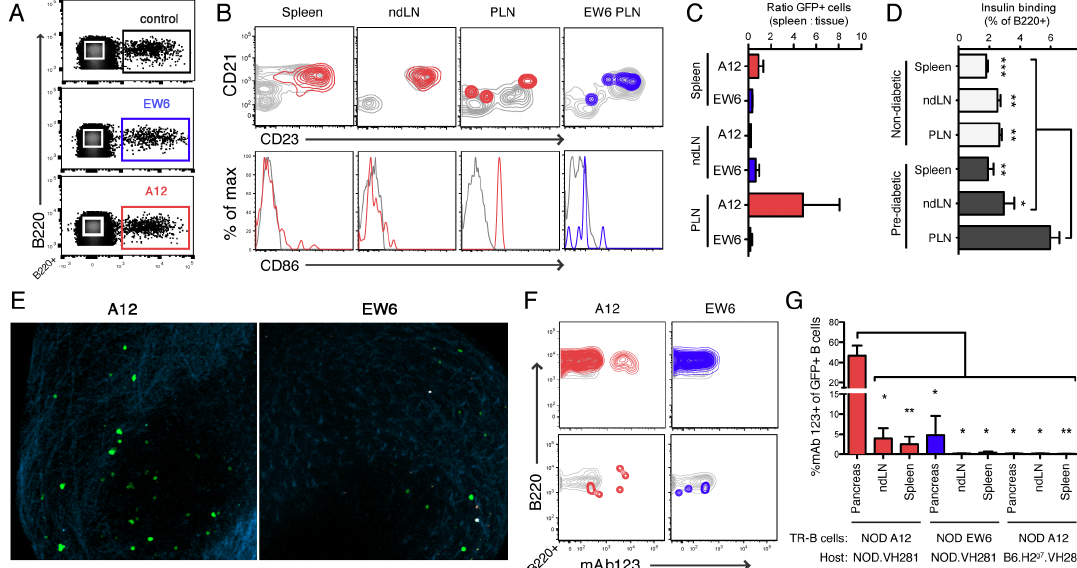
Figure 6. BCR affinity for insulin and host environment affects acquisition of autoantigen in vivo. ( A ) Adoptively transferred TR-B cells (GFP+) among B220+ splenocytes from NOD.VH281 recipients of A12, EW6, or VLA12+VH281 (control), one week post-transfer; ( B ) phenotypic comparison (CD21, CD23, and CD86) of TR-B cells (colored) to host VH281 (gray): A12 TR-B cells recovered from spleen, ndLN, PLN, as well as EW6 PLN; ( C ) ratio of TR-B cells (%GFP+) of total B cells in tissue vs. spleen; ( D ) comparison of insulin-binding B cells from non-diabetic NOD.VH125 females (blood glucose <120 mg/dL) or pre-diabetic (blood glucose 180-250 mg/dL); ( E ) 2-photon micrographs of PLNs from NOD.VH281 recipients of A12 (left) or EW6 (right) TR-B cells (GFP (green); second-harmonic generation of collagen, blue); ( F ) receptor occupancy detected by mAb123 staining of B220+ cells isolated from NOD.VH281 spleen (top) or PLN (bottom), comparing TR-B cells (colored) to host VH281 B cells (gray); ( G ) frequency of mAb123+ cells among adoptively transferred TR-B cells in NOD.VH281 or B6.H2 g7 .VH281 host animals. Data combined from five individual experiments, error bars represent SEM, Student t test used to test significance (* p < 0.05, ** p <